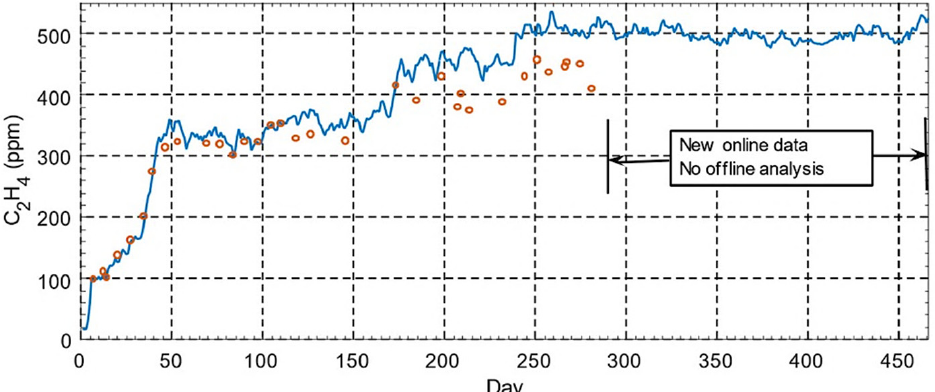
Figure 32. Evolution of ethylene concentration (C 2 H 4 ) over time, online (blue) and offline (orange) data.